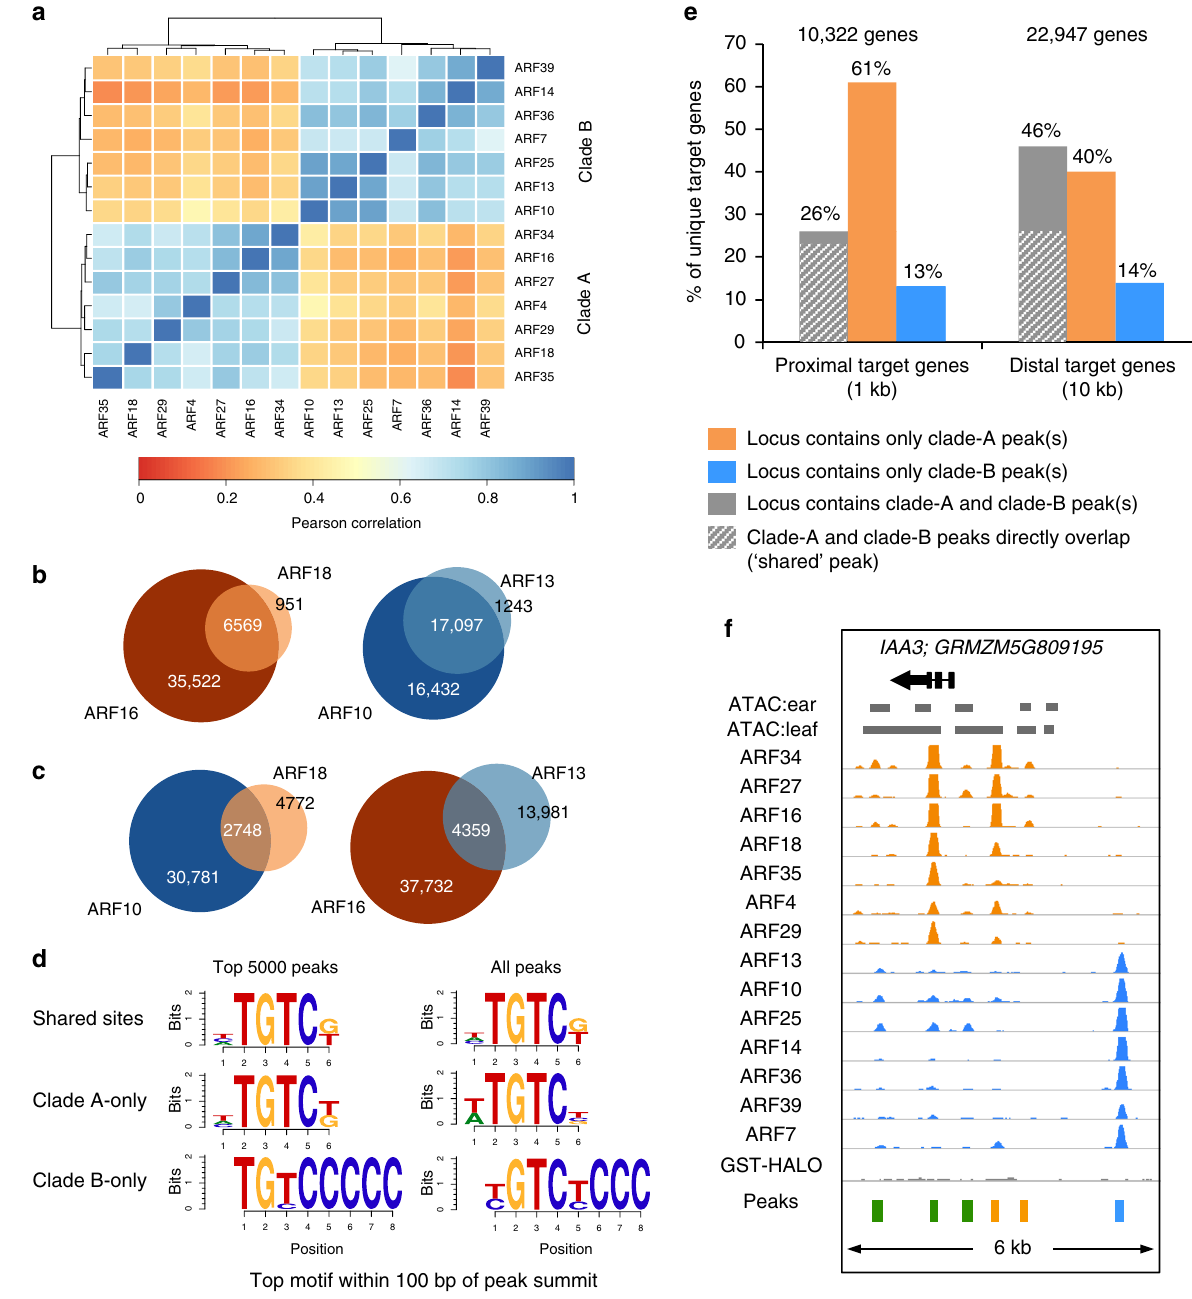
Fig. 2 Clade A and clade B ARFs bind to unique and shared sites. a Heatmap showing Pearson correlation of ARF binding events among each ARF dataset. b , c Venn diagrams showing peak overlap between representative clade A ARFs (orange) and clade B ARFs (blue). Numeric values show number of peaks. d Top motif identi fi ed for shared, clade A-only, or clade B-only sites. e Percentage of unique proximal (left) and distal (right) putative target genes that contain clade A, clade B, or both peaks. f IAA3 locus targeted by both clade A and B